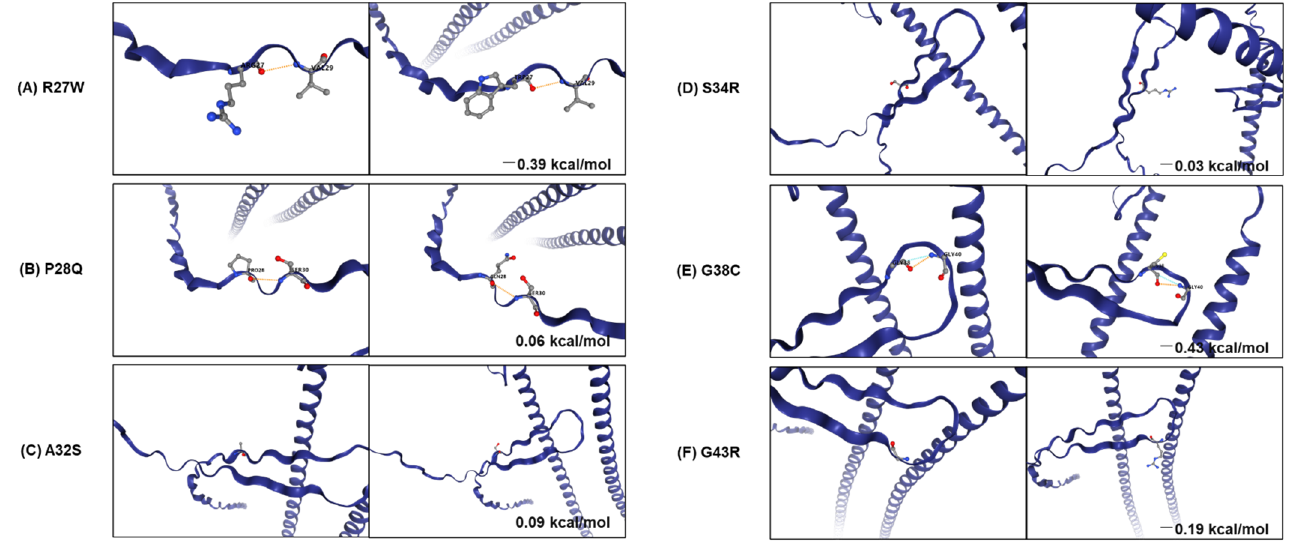
Figure 5. Analysis of stability and dynamic changes between WT and mutants in KRT18 . Stability and dynamic changes between WT ( A – C ) and five mutations ( D – F ) of KRT18 were analyzed. The figure shows the change in Gibbs free energy (in Kcal/mol) for mutations and non-covalent interactions established by the mutated residue. The orange and blue dash lines indicate polarity and van der Waals interactions, respectively. The red characteristics.